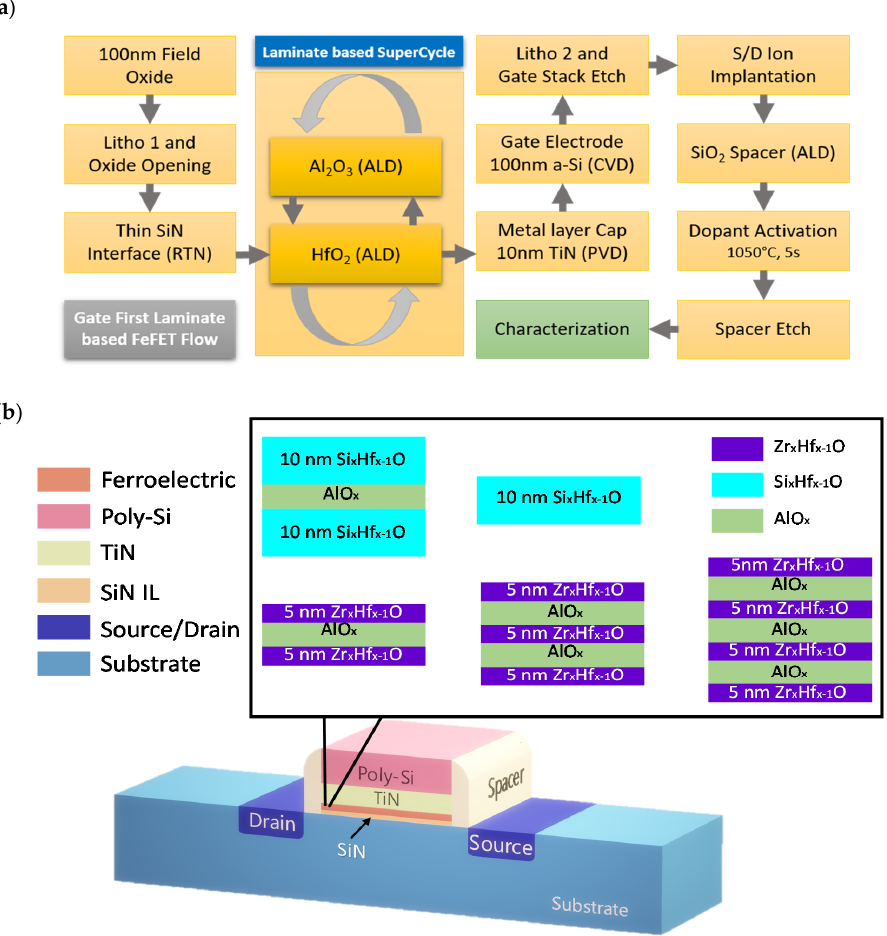
Figure 2. ( a ) The main steps of the FeFET integration with the laminate-based ferroelectric deposition step highlighted, ( b ) the laminate-based FeFET stack structure illustrated by the schematic view of the FeFET with, inset, the HSO and HZO stack flavors. Reproduced with permission from [17] T. Ali et al., IEDM; published by IEEE, Copyright 2019,